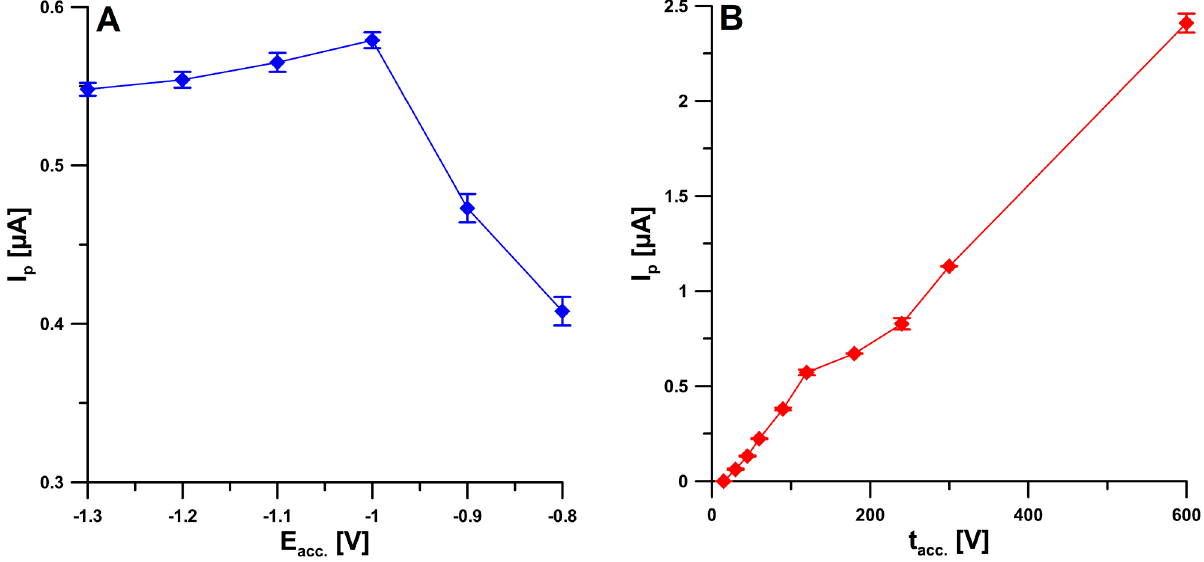
Figure 6. The dependence on E acc. ( A ) and t acc. ( B ) on the 2 nM BLM peak current. f = 50 Hz, E SW = 50 mV, and Δ E = 10 mV. The received average values of the peak current are shown with a standard deviation for n = 3.